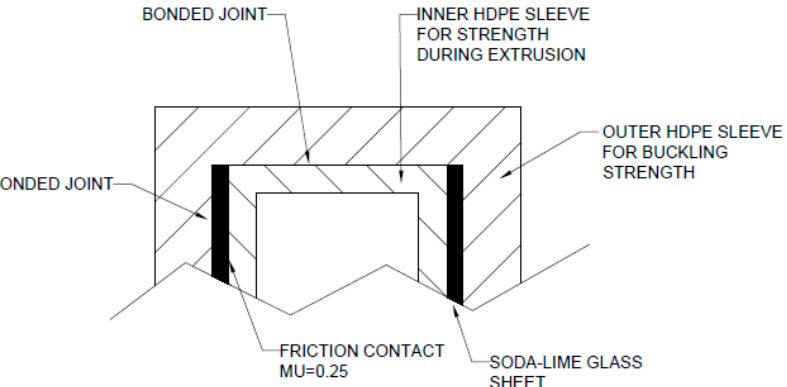
Figure 2. The bonding conditions between the inner sleeve, outer sleeve, and soda-lime glass plates is shown.